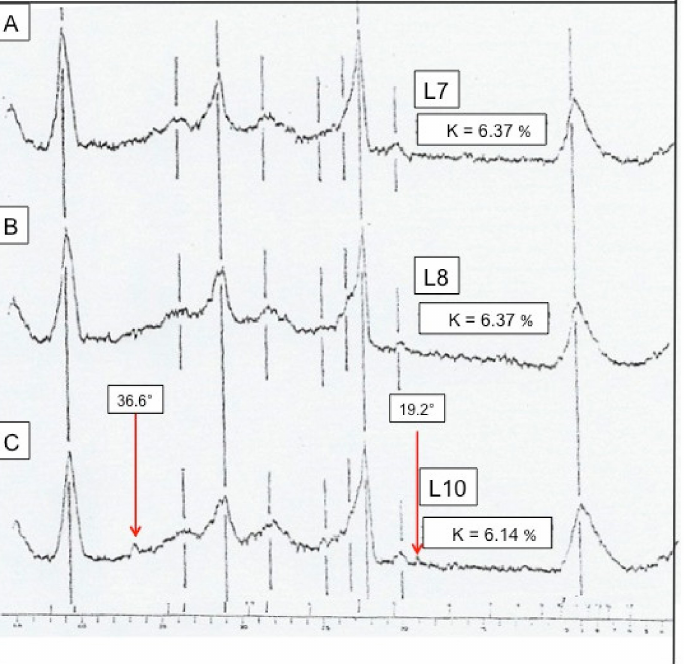
Figure 2. Copies of the original XRD diagrams of the three untreated glauconite fractions from Keppens [14]. The three diagrams A, B and C for the three samples L7, L8 and L10 are somehow fuzzy but show clearly the two peaks of the blödite mineral in the L10 sample located by the two red